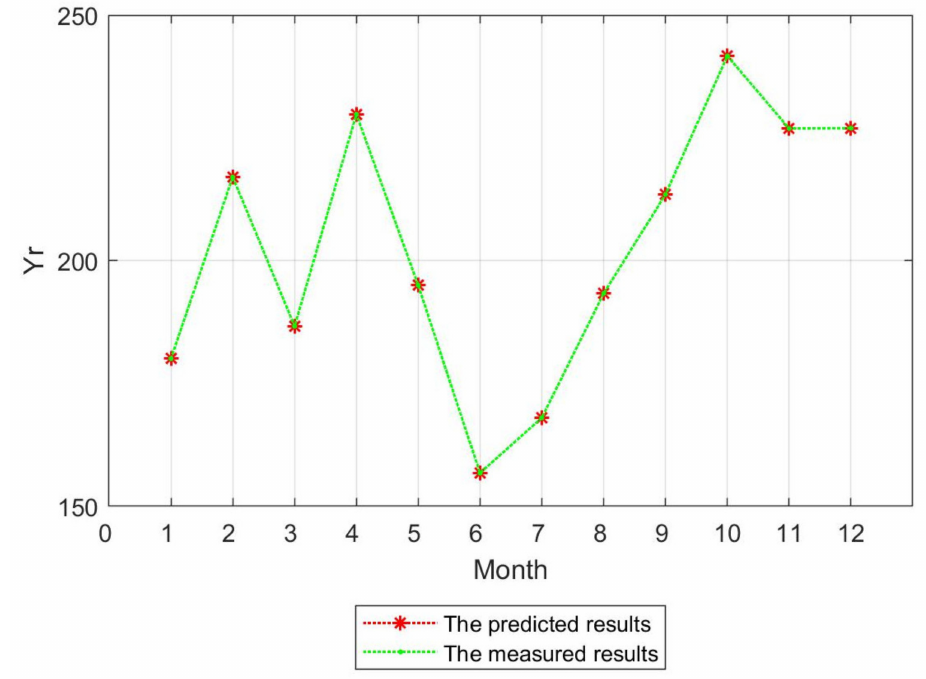
Figure 7. Monthly values of Y r .